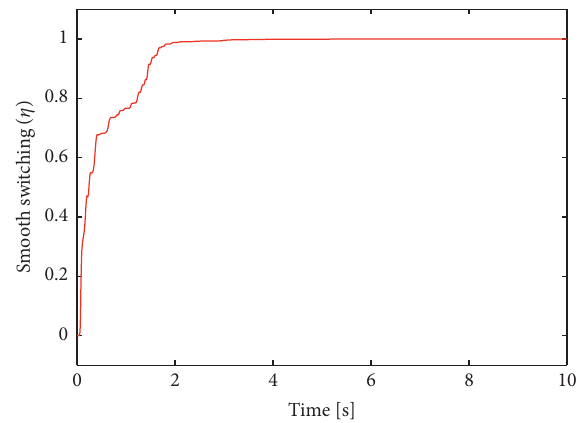
Figure 17: The smooth switching to take over between the controllers under random excitation.